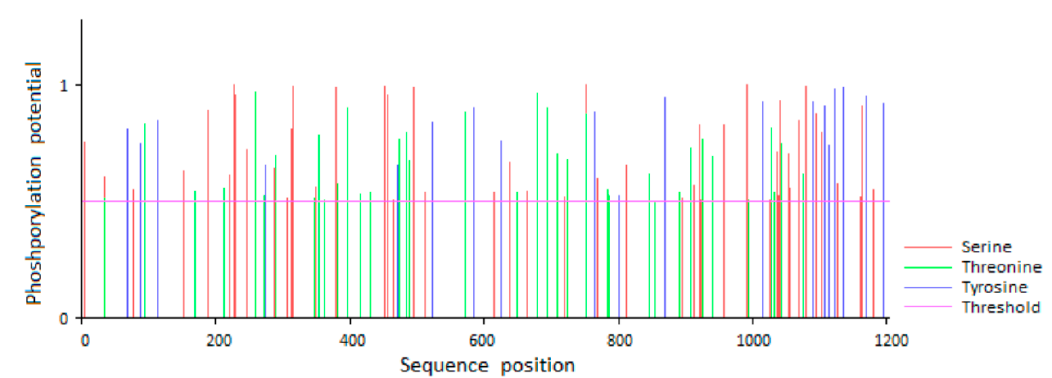
Figure 2. Prediction of the phosphorylation sites of goat EGFR. The phosphorylation sites of goat EGFR protein were predicted by NetPhos 2.0. Red color represents serine residues. Green represents threonine residues. Purple represents tyrosine residues.